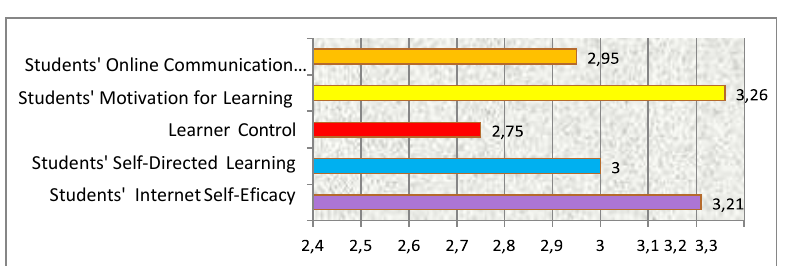
Figure 1. Overall Students’ Online Learning Readiness